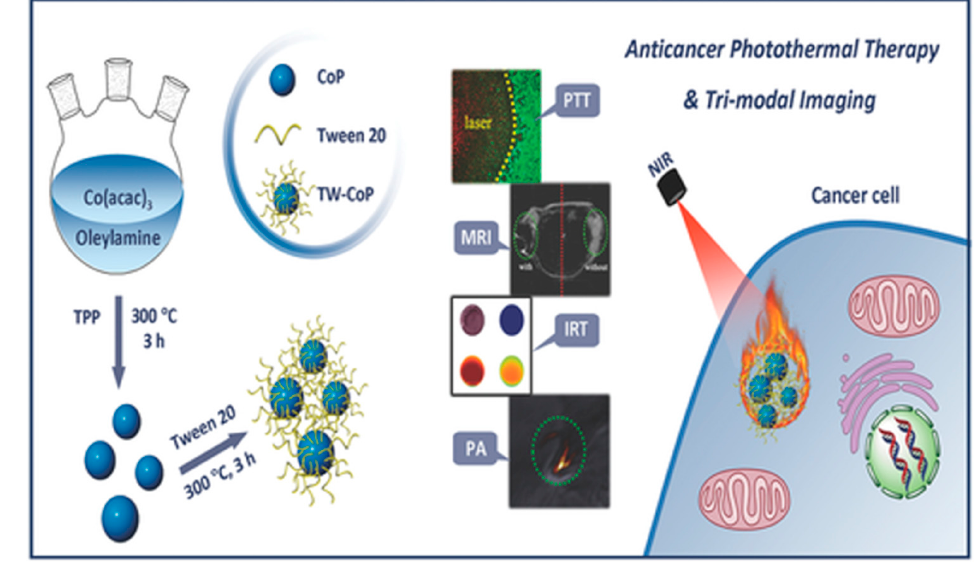
Figure 6. Synthesis and biomedical applications of CoNPs in PTT [132].